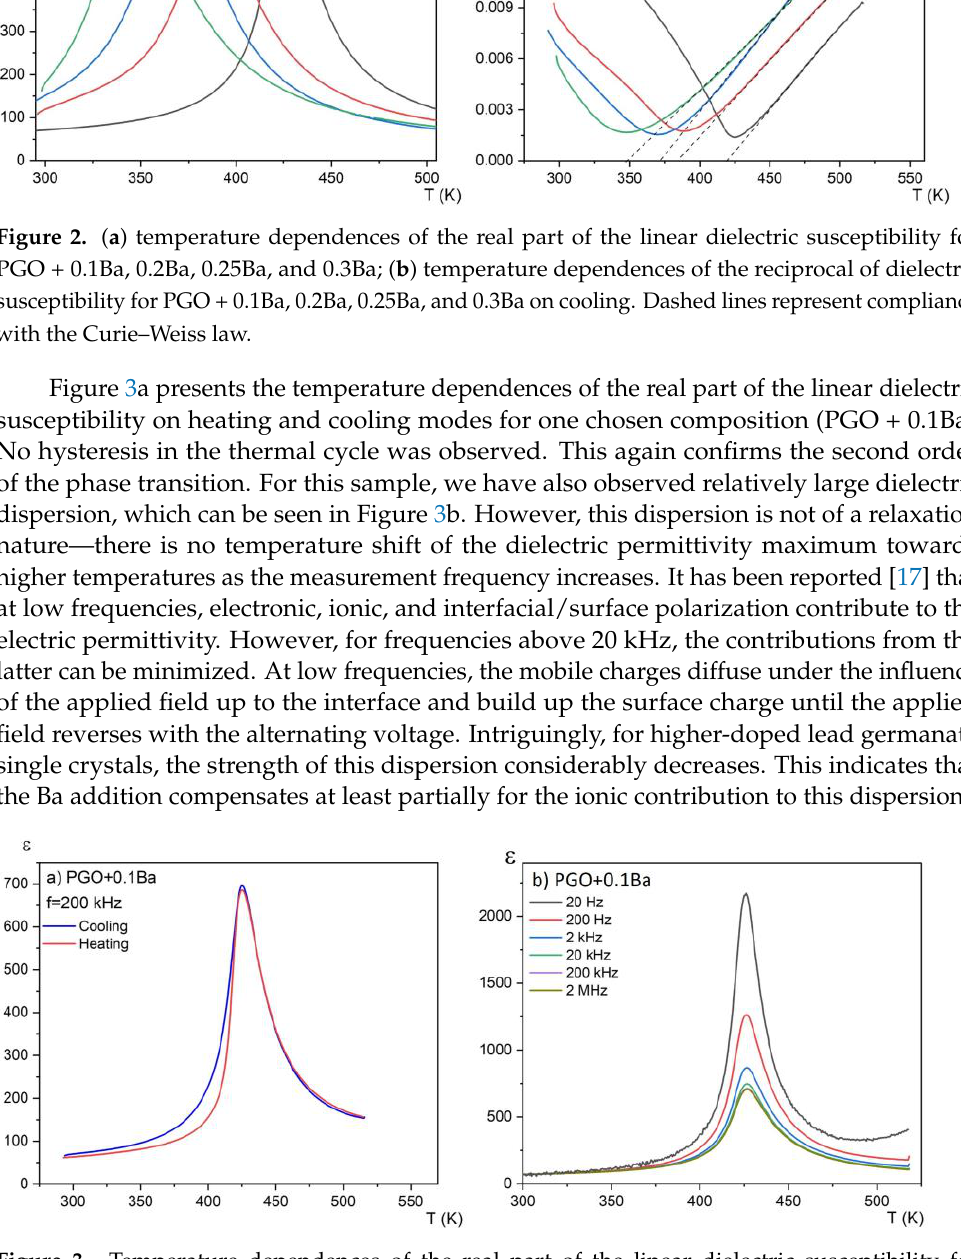
Figure 3. Temperature dependences of the real part of the linear dielectric susceptibility for PGO + 0.1Ba ( a ) on the heating and cooling modes; ( b ) for a set of different frequencies on cooling.